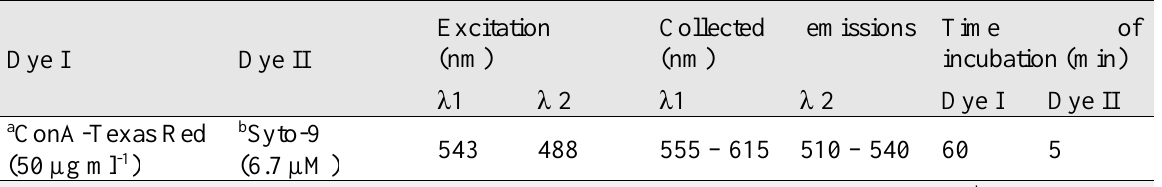
Table 3. Dyes used for visualization of biofilms by using fluorescence microscopy.